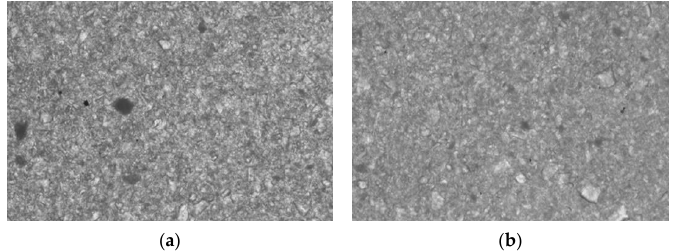
Figure 2. Aspect of ceramic suspensions after solubilization in PBS using ultrasounds: ( a ) Group 5 (GC) and ( b ) Group 6 (BC). The photos were taken using a 20× lens.